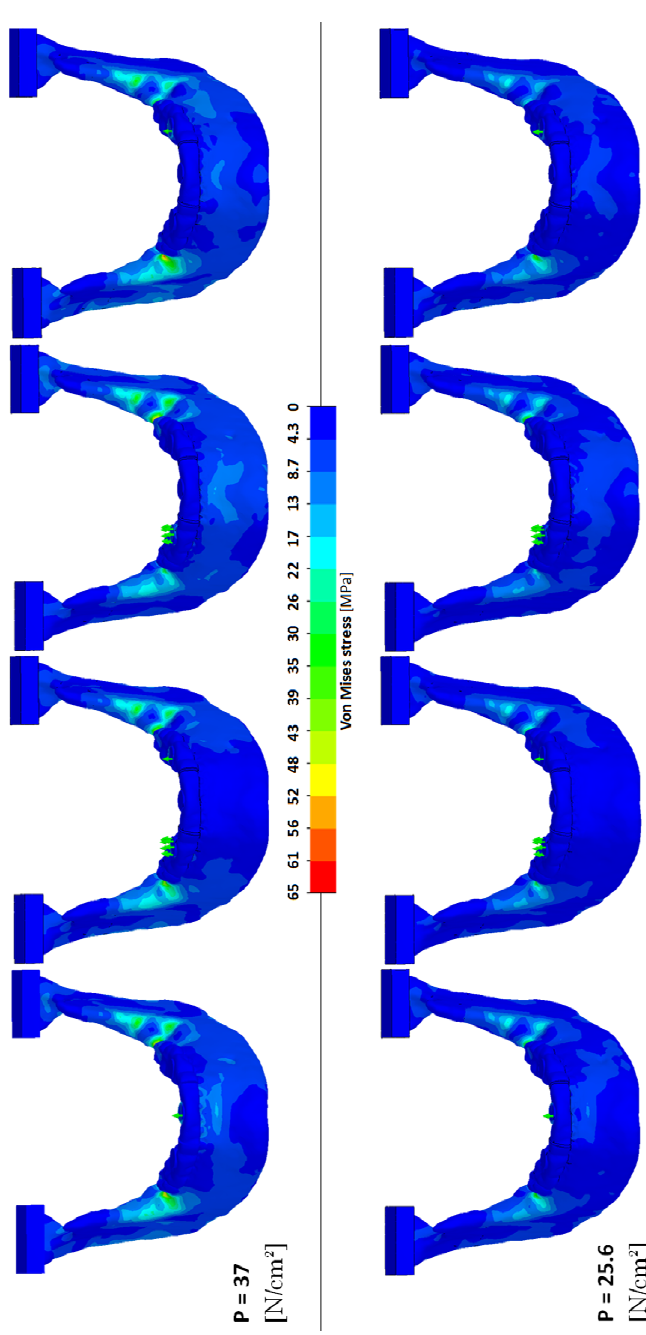
Figure 3. Visualisation of the von-Mises stress occurring in all the FEA scenarios of our 56 y.o. subject. Left to right: incisal, bilateral premolar, unilateral premolar right, and unilateral premolar left